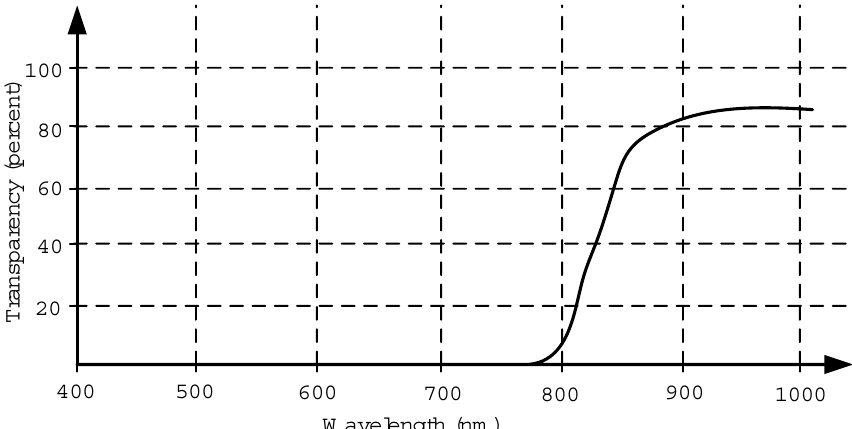
Figure 9. Transparency of the selected infrared